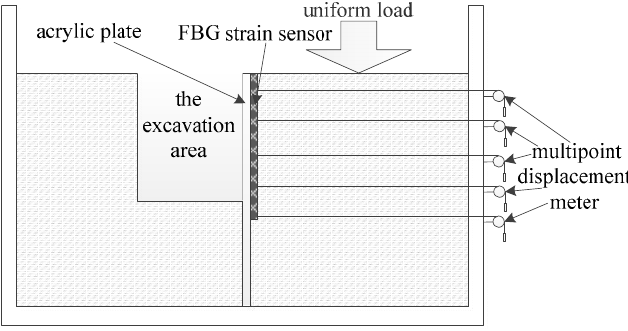
Figure 9. Experiment Scheme of the test model.